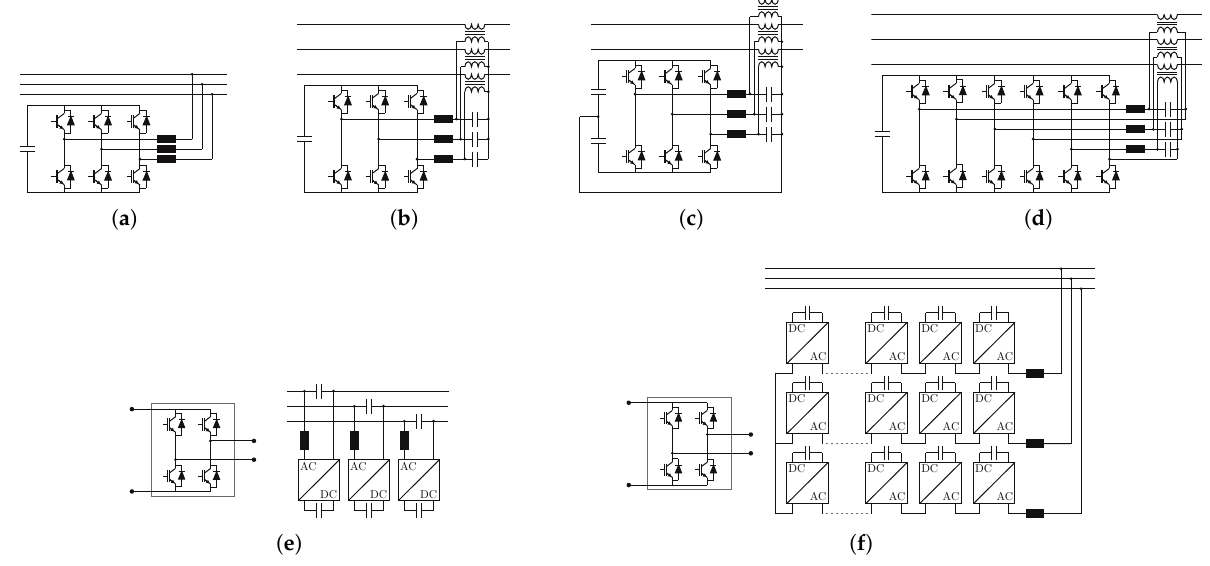
Figure 6. DC/AC power converter topologies. ( a ) Three-phase two-level converter. ( b ) Three-phase two-level converter with CTs. ( c ) Three-phase two-level converter with split capacitor and CTs. ( d ) H-bridge converter per phase with common DC-Link. ( e ) H-bridge converter per phase with independent DC-Link. ( f ) Cascaded H-bridge